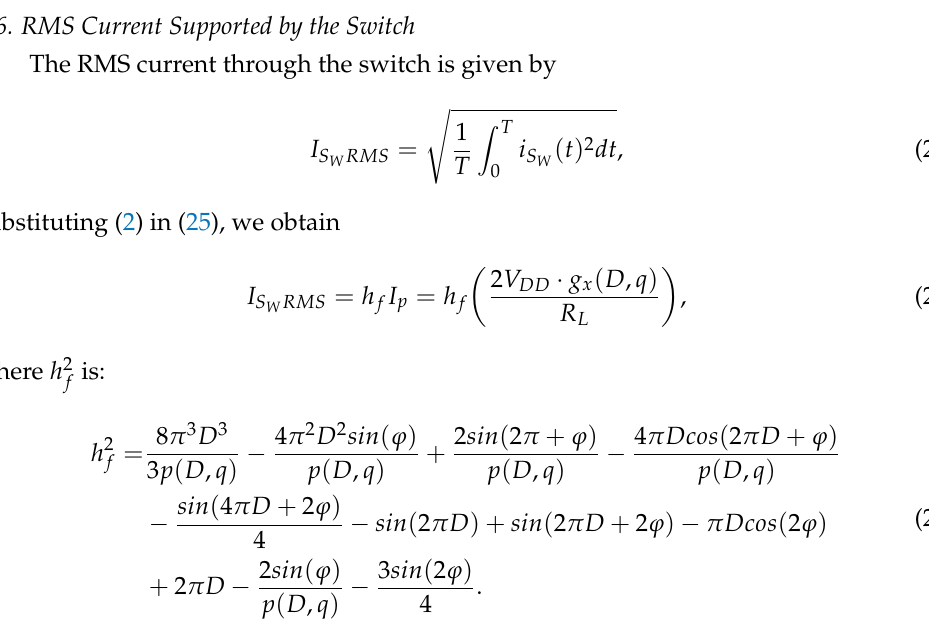
Figure 5. Switch current behavior. ( a ) Waveform for D = 0.5. ( b ) Waveform for D =